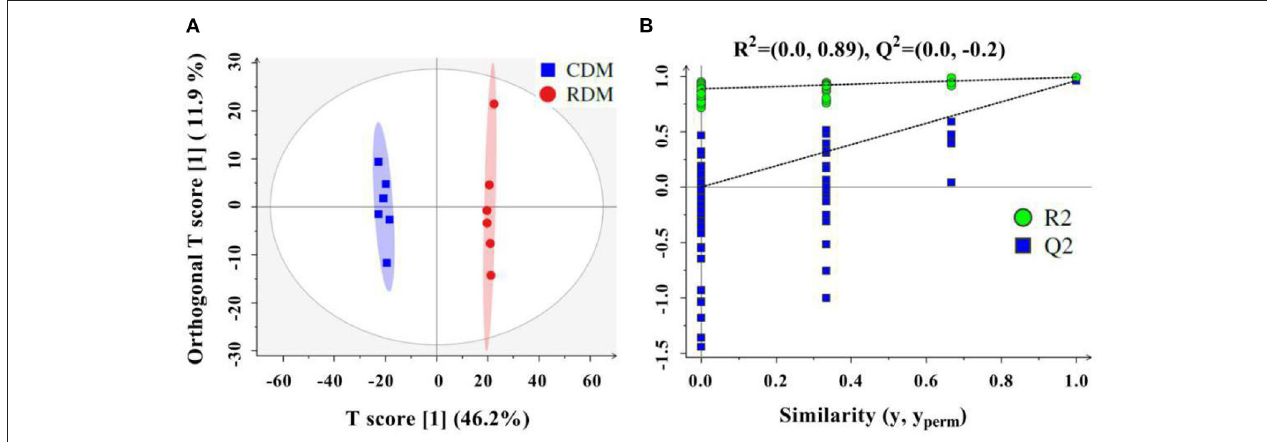
FIGURE 4 | Orthogonal projections to latent structures discriminant analysis (OPLS-DA) in cooked and raw donkey muscles. (A) OPLS-DA score plots based on lipidomic data from cooked and raw donkey muscles ( R 2 X = 0.581, R 2 Y = 0.996, Q 2 = 0.95) and (B) corresponding OPLS-DA validation plots ( R 2 = (0.0, 0.89), Q 2 = (0.0, −